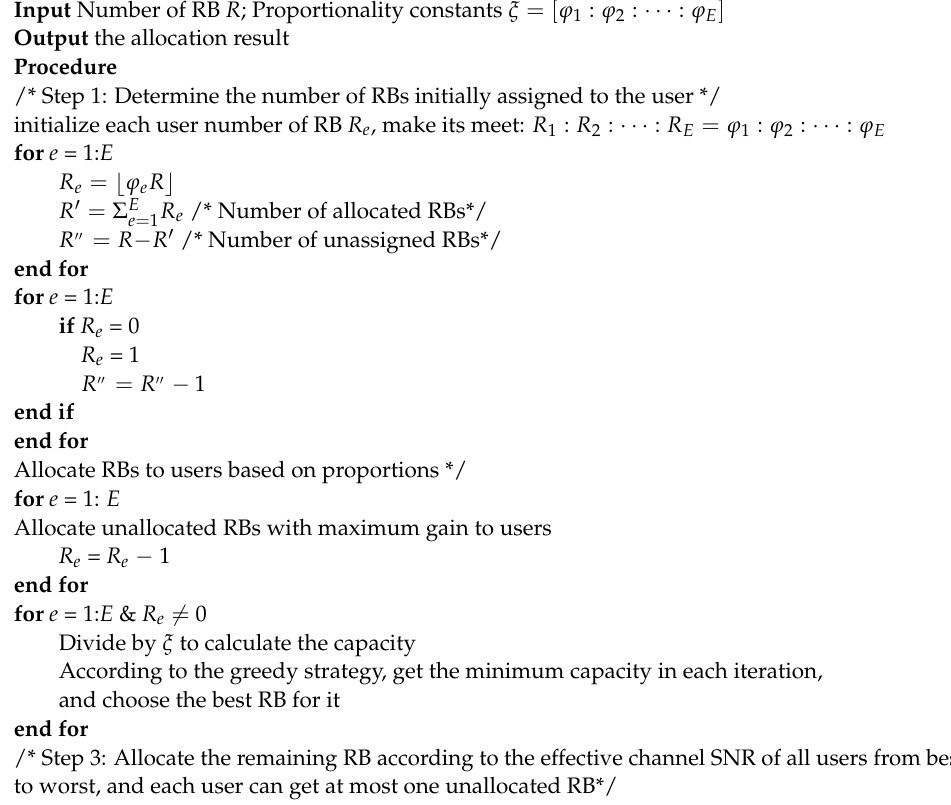
Algorithm 1. RB allocation based on greedy